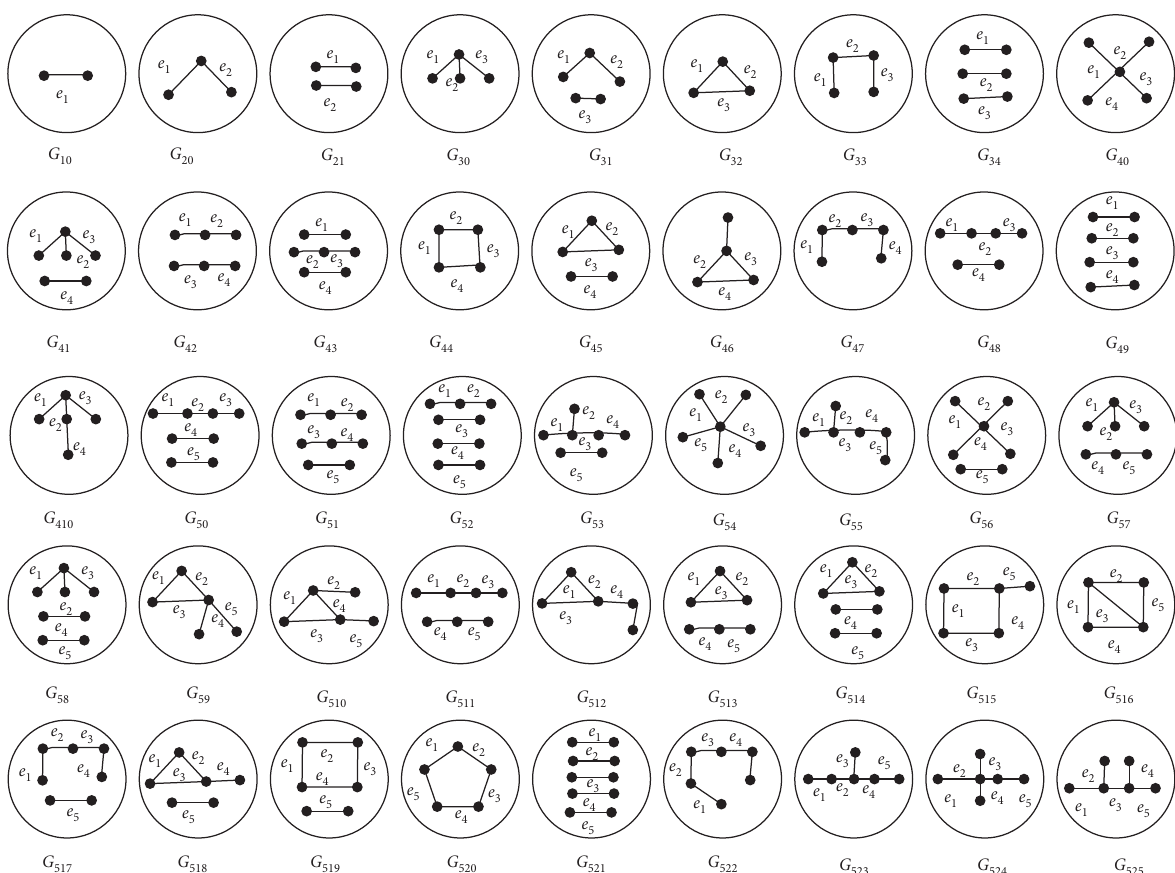
Figure 1: The graphs obtained from K Table 1: The numbers of triangles of some graphs in G Graph c